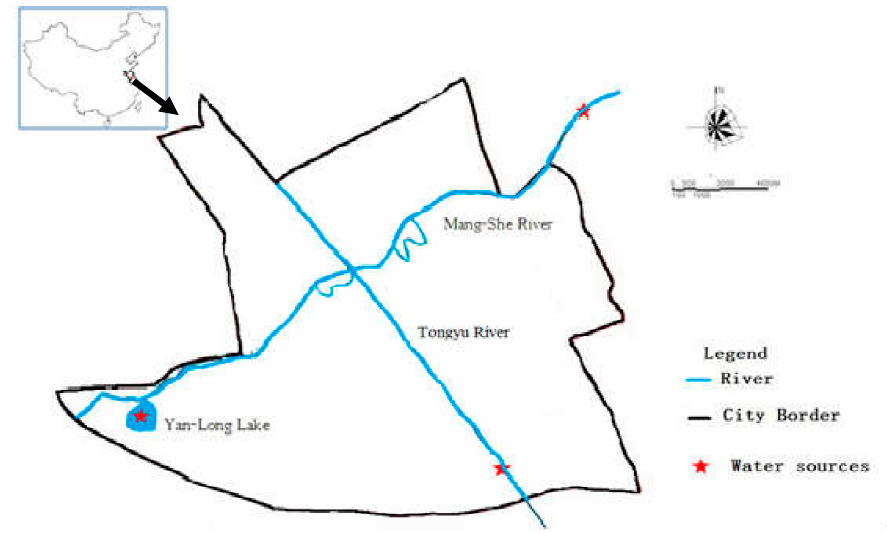
Figure 1. The drinking water sources in Yancheng